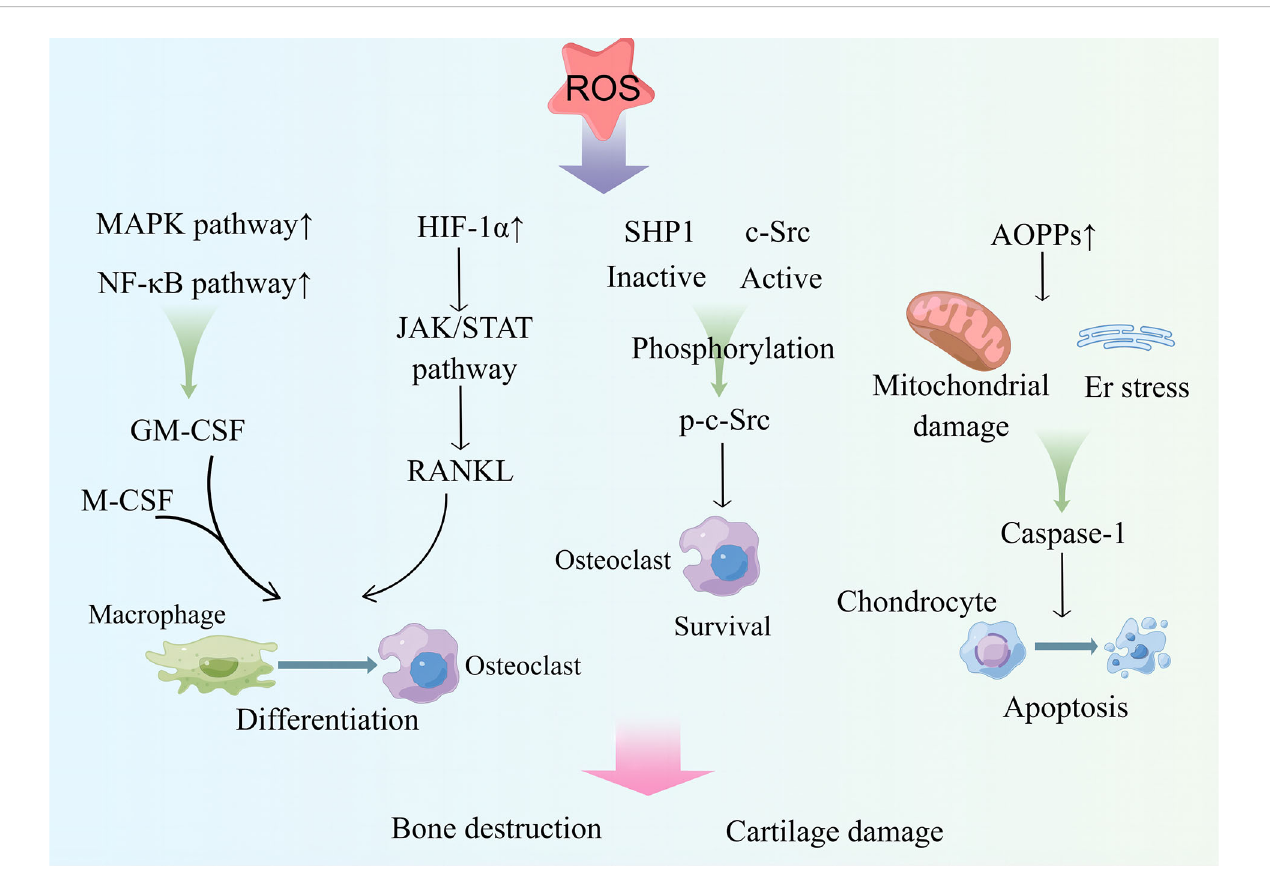
FIGURE 3 ROS upregulates MAPK and NF- k B pathway activities and transcribes GM-CSF, which acts in conjunction with M-CSF to induce osteoclast differentiation. ROS can upregulate the expression of HIF-1 a , activate the JAK/STAT pathway, induce RANKL production, and promote osteoclast differentiation. ROS activate c-Src for osteoclast survival by inactivating SHP1. ROS drive the production of AOPPs, causing ER stress and mitochondrial damage; produce caspase-1; and drive chondrocyte apoptosis. These processes play an important role in bone destruction and cartilage destruction in RA. MAPK, mitogen-activated protein kinase. GM-CSF, granulocyte macrophage colony-stimulating factor. HIF-1 a , hypoxia-inducible factor. JAK, Janus kinase; STAT, signal transducer and activator of transcription; RANKL, receptor activator of NF- k B ligand; SHP1, Src homology 2 domain-containing phosphatase 1; AOPPs, advanced oxidation production products. By